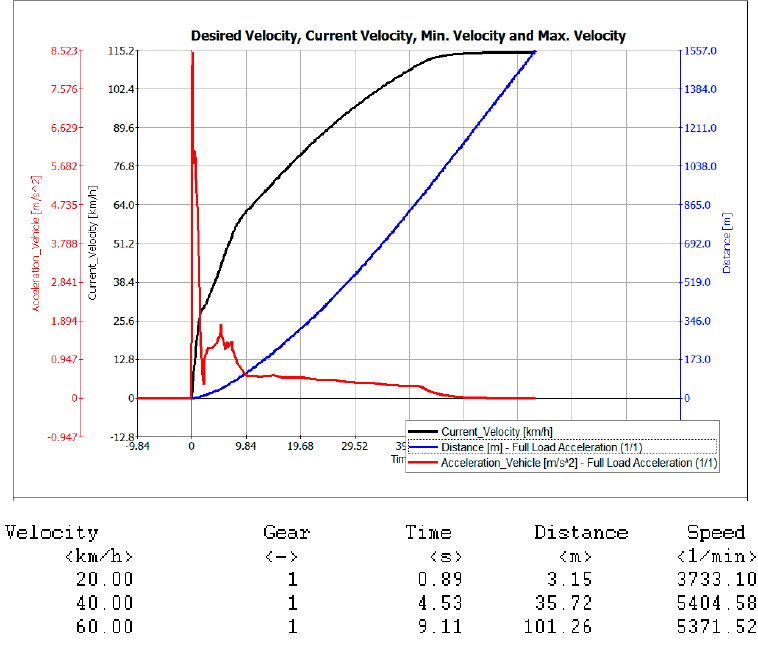
Figure 5. The full load acceleration performance test of the vehicle.